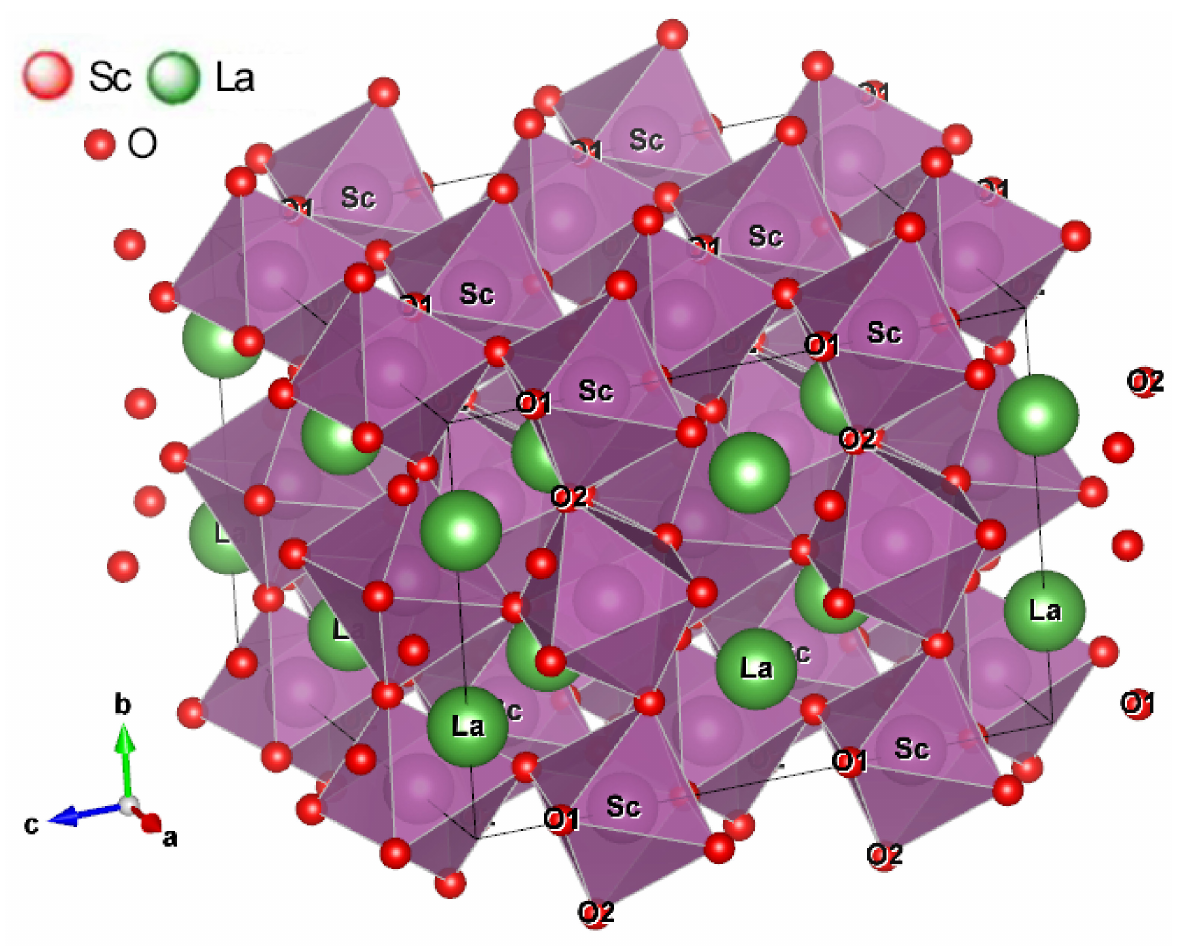
Figure 1. Initial crystal structure of LaScO 3 in the absence of a proton: large circles denote the A-site cations, the regions bounded by octahedra shows the localization of the B-site cations, and small circles denote oxygen